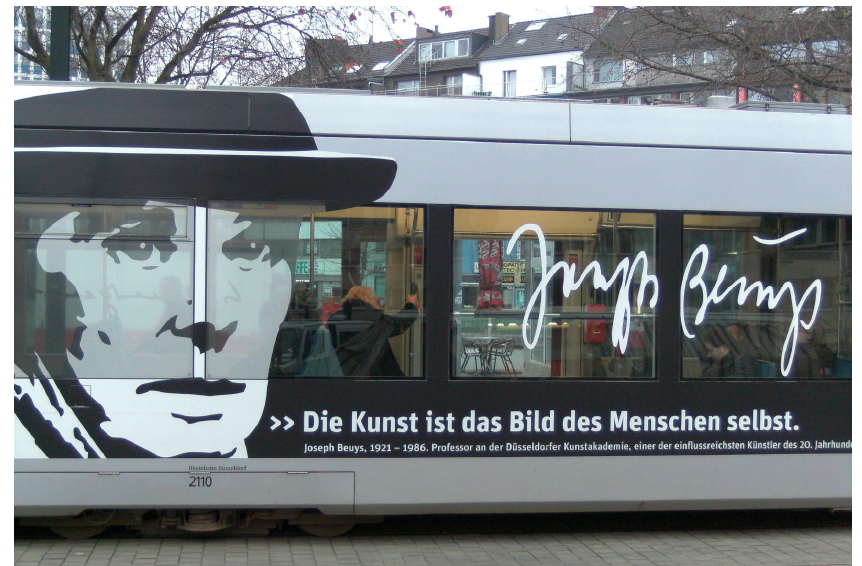
Figure 5. Beuys’ portrait on a tram in Düsseldorf with his famous sentence “ Die Kunst ist das Bild des Menschen selbst ” (Art is the image of man himself) [81].